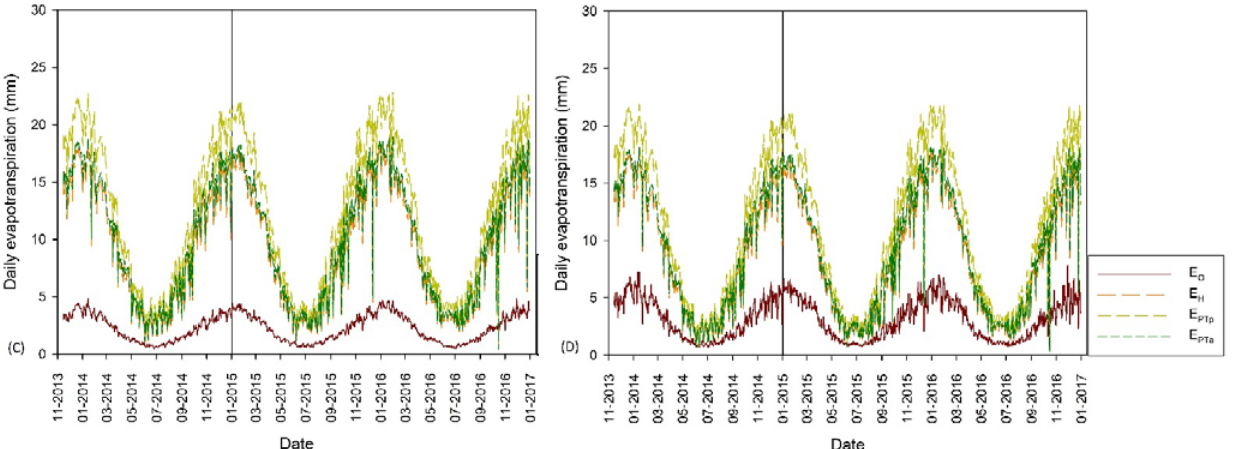
Figure 6. Daily potential/actual evapotranspiration for: Q2 ( A ), Q3 ( B ), BLQ1 ( C ) and BLQ2 ( D ) using Oudin model (E O ), Hargreaves–Samani (E H ) model, potential Priestley–Taylor (E TPp ) model and actual Priestley–Taylor (E TPa ) model, in the calibration and validation period. Vertical lines represent the end of calibration period (right) and beginning of validation period (left).